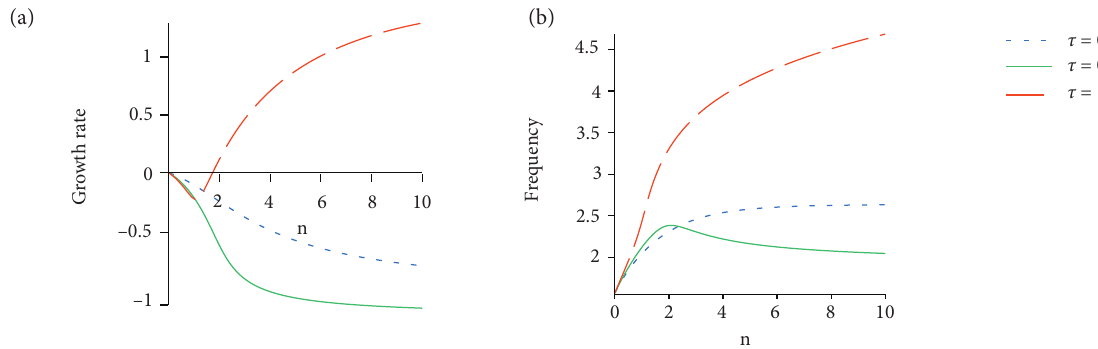
Figure 5. Thermoacoustic characteristics of a duct (1L mode, x